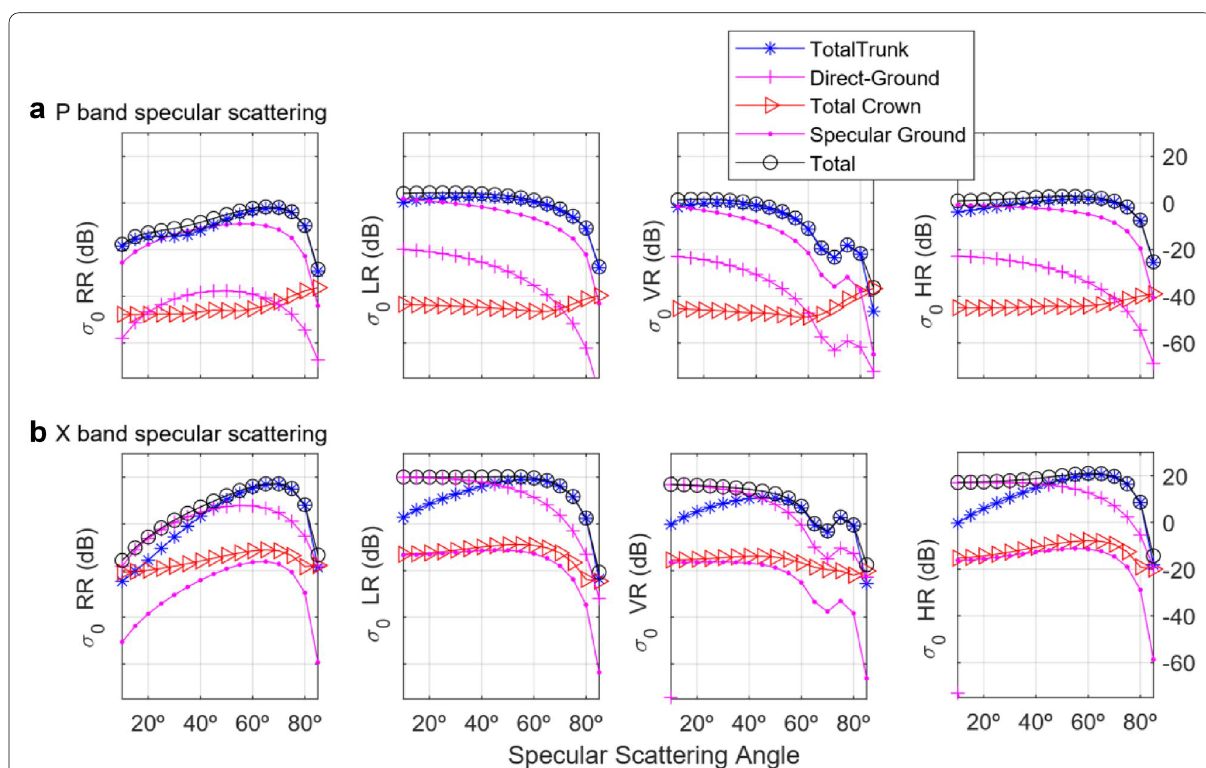
Fig. 7 a P and b X bands canopy scattering contributions versus scattering angle at the specular plane for various